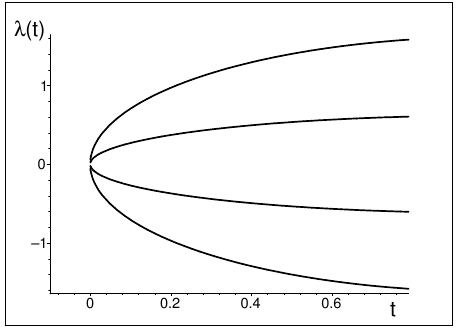
Figure 2. The reality of the spectrum of non-Hermitian matrix (3) at not too large t ≥